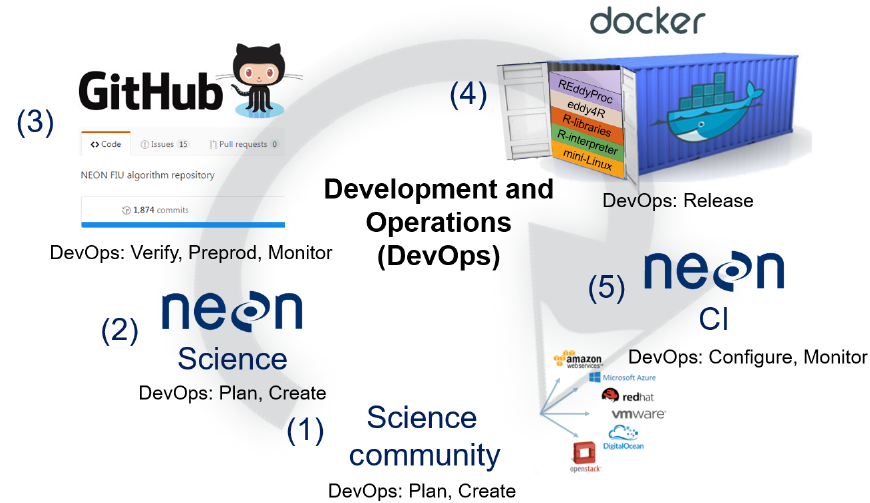
Figure 2. NEON-specific DevOps workflow, with references to corresponding steps in Fig. 1. Please see text in Sect. 2 for a detailed